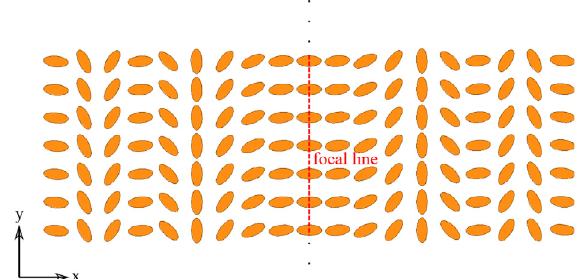
Figure 7. The 1D-focusing transmitarray is designed to focus the incident normal beam into a focal line at the center (red dashed line). Each unit cell is rotated according to its position to compensate the free space path